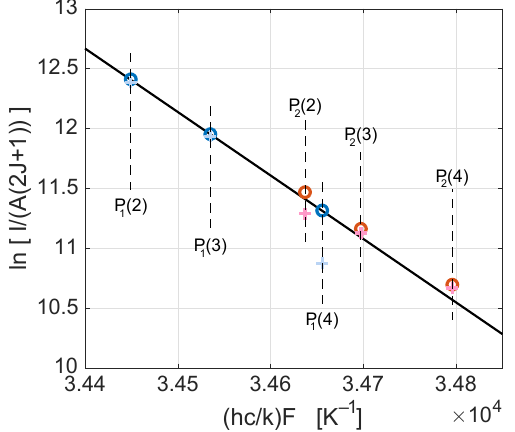
Figure 3. Boltzmann plot determined from the OH(8–3) P-branch lines shown in the HiTIES spectrum from Fig. 2, taken on 23 De- cember 2003 at 22:30UT, with an integration time of 120s. Blue symbols represent P 1 lines, and red symbols are P 2 lines. Crosses indicate intensities as measured by the HiTIES instrument, whereas open circles have been corrected for water vapour absorption. The solid black line is a linear fit to the water-vapour-corrected P 1 lines. The slope of this fit gives a rotational temperature of T = 188 .